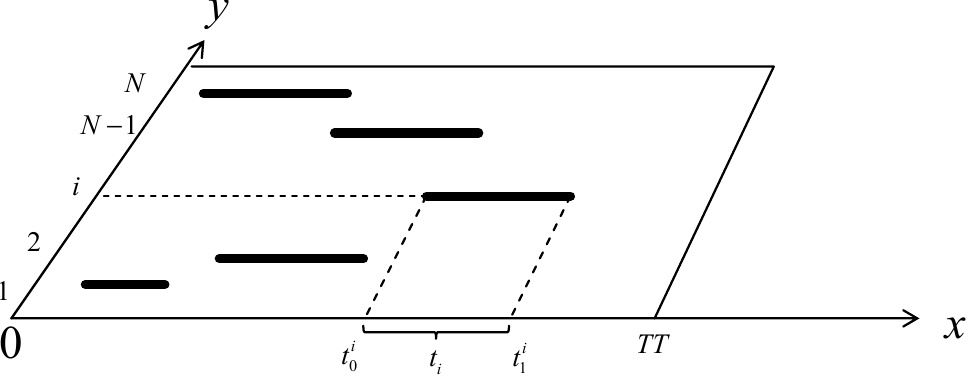
Figure 1. Schematic diagram of the operation rules of drainage works. 𝑥 is time; 𝑦 is the serial number of the drainage work.